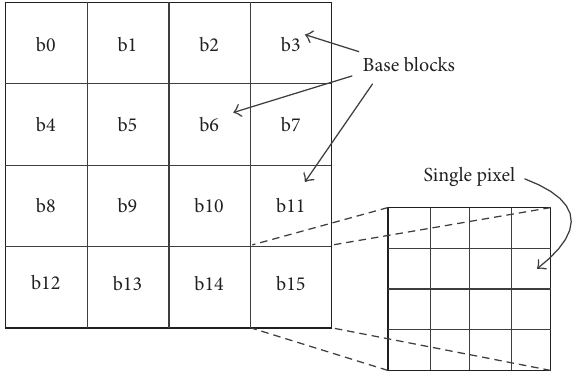
Figure 4: 16 × 16 macroblock segmented into 16—4 × 4 submac- roblock